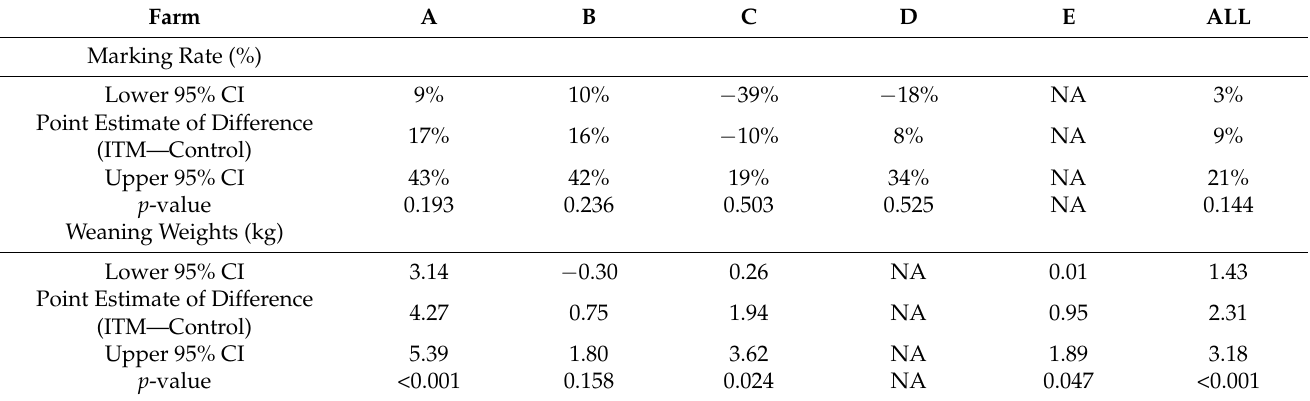
Table 2. Differences in marking rates and weaning weights (point estimates of ITM minus Control, 95% Confidence Intervals for the difference and observed p -values) for lambs born to ewes treated with injectable trace minerals (ITM) and control